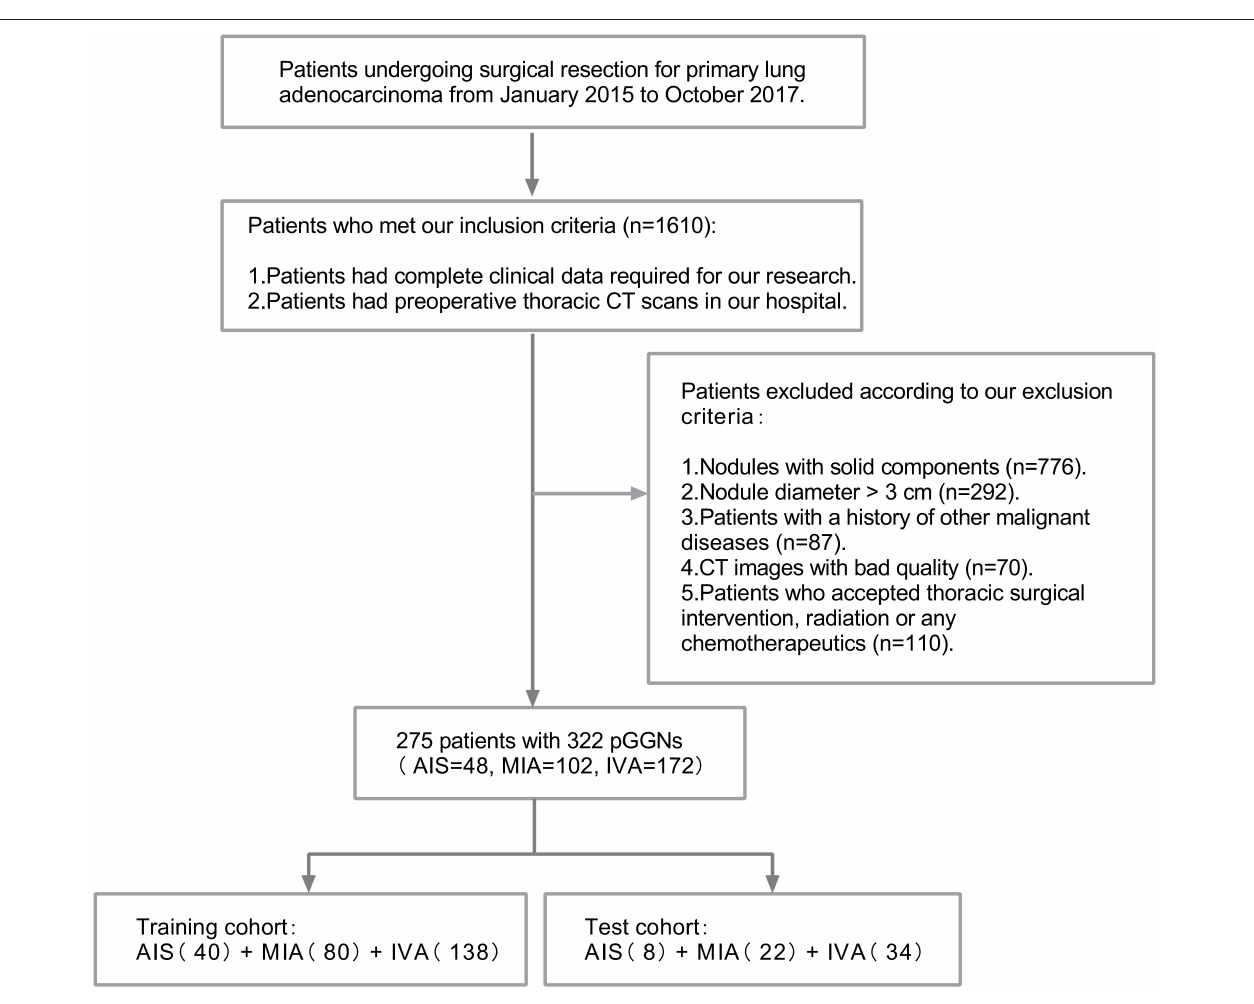
FIGURE 1 | The flowchart of patient